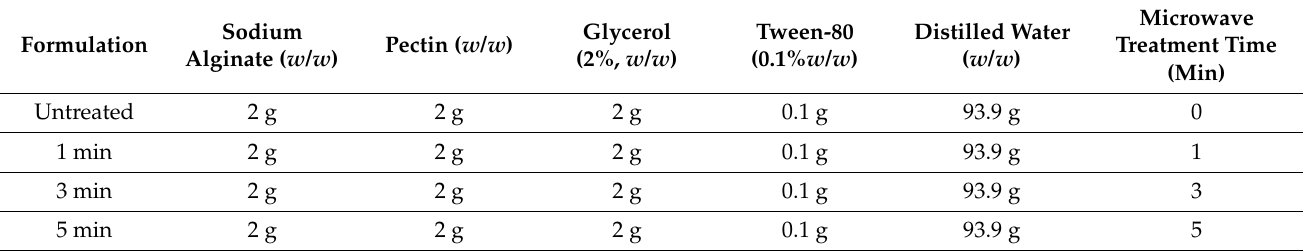
Table 1. Different formulations of sodium alginate pectin blend film that were microwave treated.